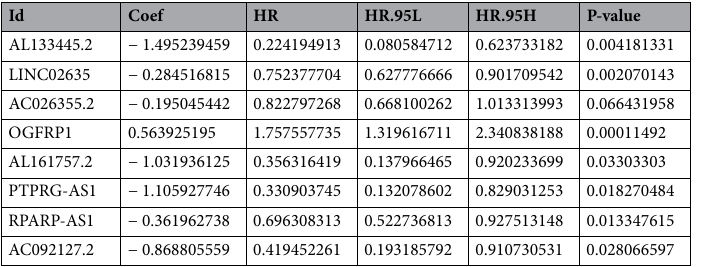
Table 2. Coefficients and multivariable Cox model results of 8 lncRNAs in the cuproptosis-related prognostic